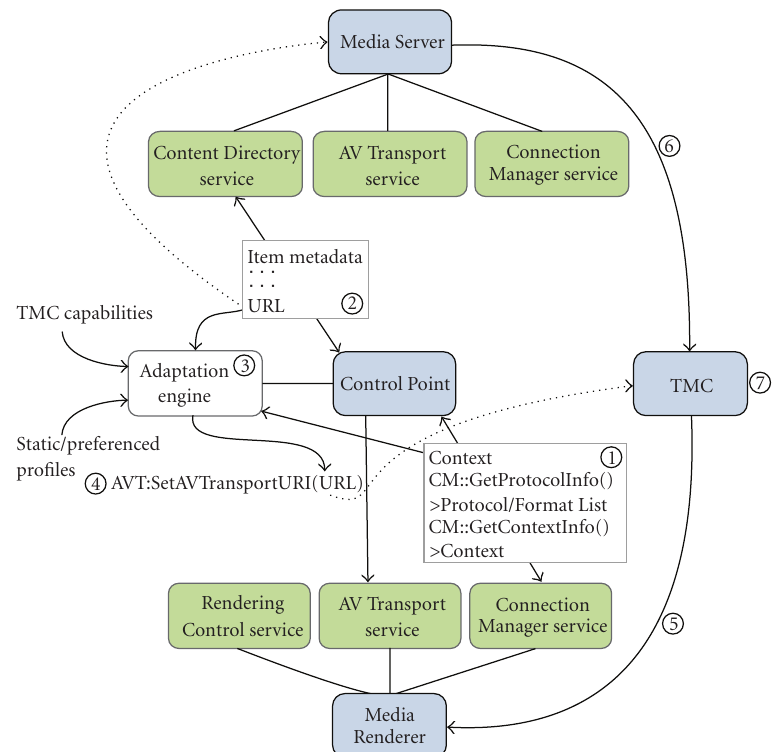
Figure 5: Action call sequence of the Context-aware UPnP-AV Control